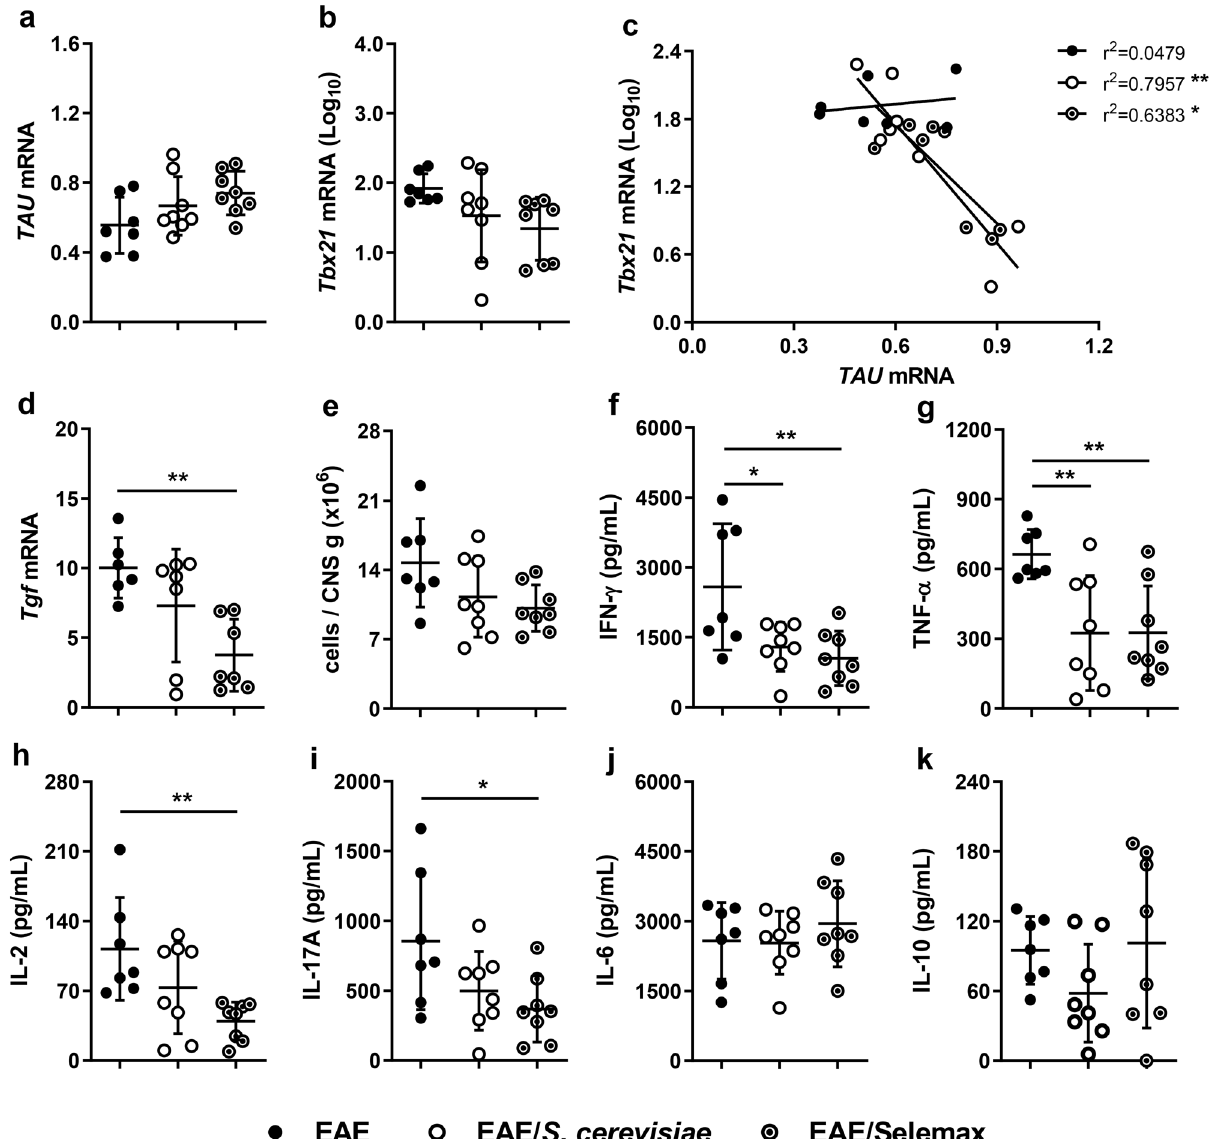
Figure 3. Effect of S. cerevisiae and Selemax on CNS inflammatory markers. EAE mice received 14 oral doses of S. cerevisiae or Selemax. The mRNA expression of TAU ( a ), Tbx21 ( b ) and Tgf ( d ) were performed in lumbar spinal cord samples and the correlation coefficient between TAU and Tbx21 was established ( c ). Total number of leukocytes eluted from the CNS adjusted per gram of tissue ( e ). CNS cell cultures (5 × 10 5 ) were stimulated with MOG 35-55 (50 µg/mL) for 48 h and the production of IFN-γ ( f ), TNF-α ( g ), IL-2 ( h ), IL-17A ( i ), IL-6 ( j ) and IL-10 ( k ) were assessed in the supernatants. Statistical analysis was performed by one-way ANOVA and subsequent Tukey’s test ( a , b , d – j ) and Pearson correlation ( c ). All data were expressed as the mean ± SD and statistical differences were represented by * p < 0.05 and ** p < 0.01. Two independent experiments were combined, n = 7–8 mice/group. The graphs were created using GraphPad Prism v.8.0.2 and image was modified with Adobe Photoshop DC (CD11b - CD103 + ) (Fig. 5f) indicated that selenization can increase the tolerogenic potential of S. cerevisiae . Concerning CD11b + DC subsets, the proportion of CD11b + CD103 - DC (Fig. 5g) was significantly reduced in both EAE/ S. cerevisiae ( p = 0.0363) and EAE/Selemax ( p = 0.0044) groups and CD11b + CD103 + DC (Fig. 5h) was reduced only in EAE/Selemax ( p = 0.0141). The percentage of CD11b - CD103 + tolerogenic DC was higher in both EAE/ S. cerevisiae ( p = 0.0379) and EAE/Selemax ( p = 0.0095) groups in comparison to EAE group (Fig. 5i). Despite this, tolerogenic DC from EAE/Selemax expressed a significantly higher amount of PD-L1 ( p = 0.0197) in comparison to EAE group (Fig. 5j). The same profile was observed in non-EAE mice (control group). Only Selemax supplementation increased the percentage of CD4 + CD25 + Foxp3 + cells ( p = 0.0190) and CD11b - CD103 + tolerogenic DC ( p = 0.0502) (Supplementary Fig. 1a and 1b, respectively).